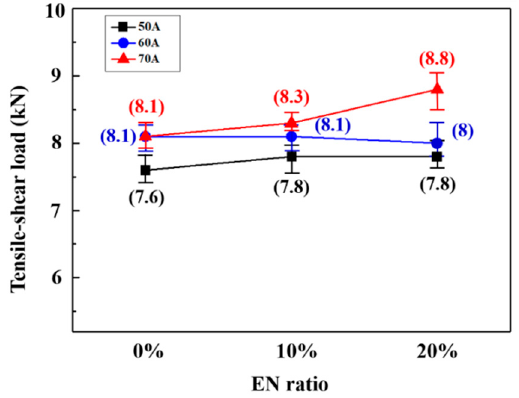
Figure 5. Comparison of tensile shear load of dissimilar braze-welded joints with different welding Appl. Sci. 2021 , 11 , x FOR PEER REVIEW